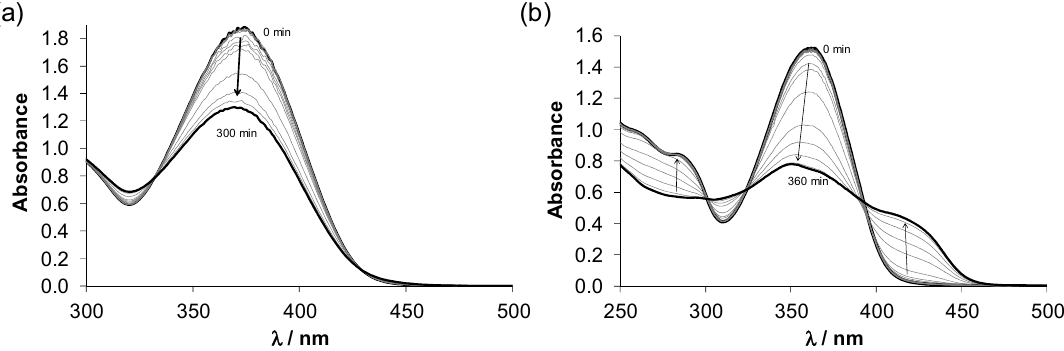
Figure 2. Time-dependent UV–Vis spectra of ( a ) HL 1 and ( b ) HL 2 at physiological pH {c L = 100 µ M; pH = 7.40 (20 mM HEPES); T = 298 K; I = 0.10 M (KCl); ℓ = 1.0 cm; 1% ( v / v ) DMSO}.